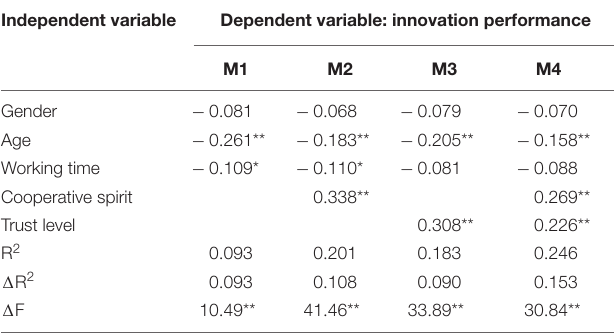
TABLE 3 | Regression analysis of Member relationship on innovation